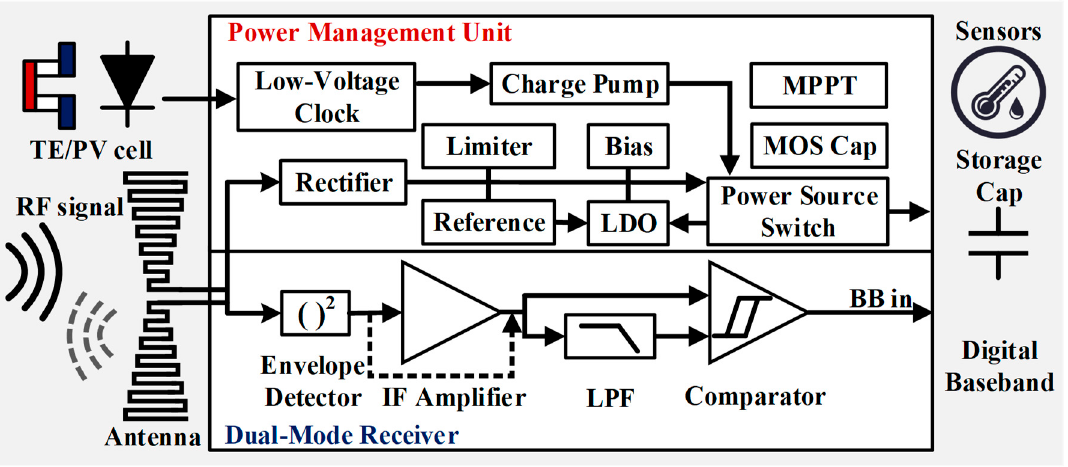
Figure 2. Proposed self-powered RFID tag architecture.